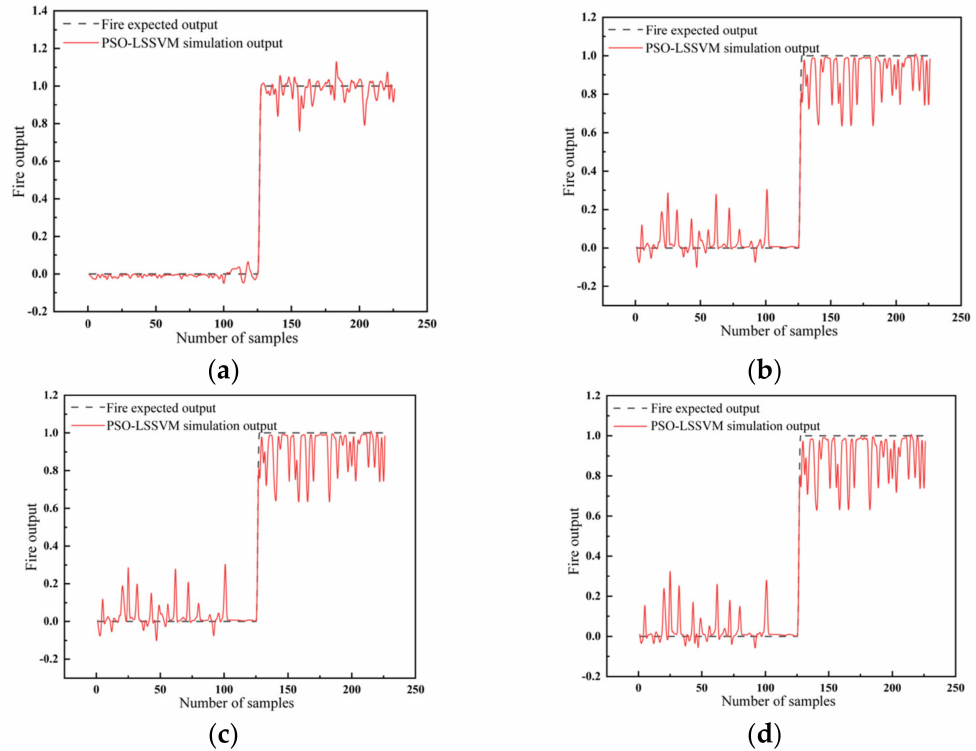
Figure 9. The output results of fire with the LSSVM for different kernel functions: ( a ) the radial basis kernel function; ( b ) the sigmoid kernel function; ( c ) the polypolynomial kernel function; ( d ) the linear kernel function.